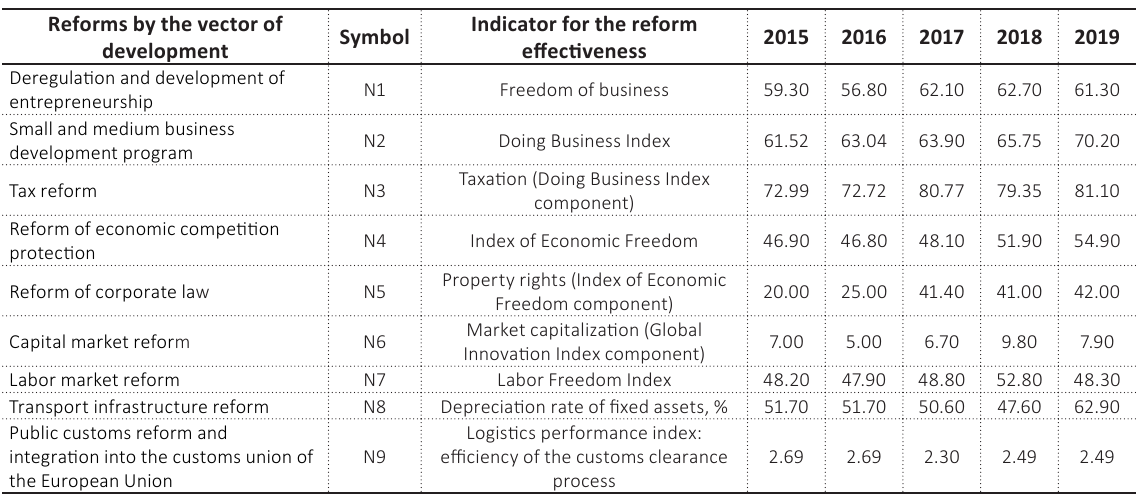
Table 2. The value of international indices as an indicator of assessing the implementation of